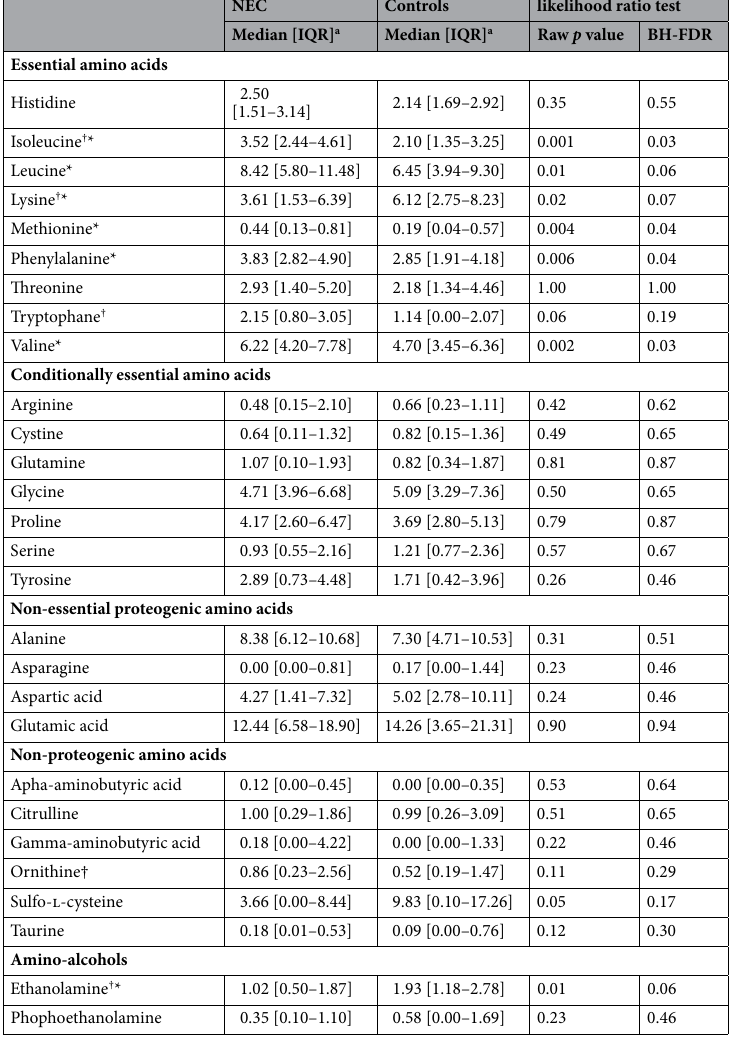
Table 2. Relative amino acid and amino alcohol (AAA) concentrations (% of total AAA concentration) in cases vs. controls on pooled samples from 3 to 1 day(s) before diagnosis. BH-FDR Benjamini–Hochberg False Discovery Rate as determined by univariate analysis, IQR interquartile range. a Median and IQR of percentage of total amino acids concentration; *Significance level of BH-FDR < 0.1; † Markers of the rendered model by multivariate